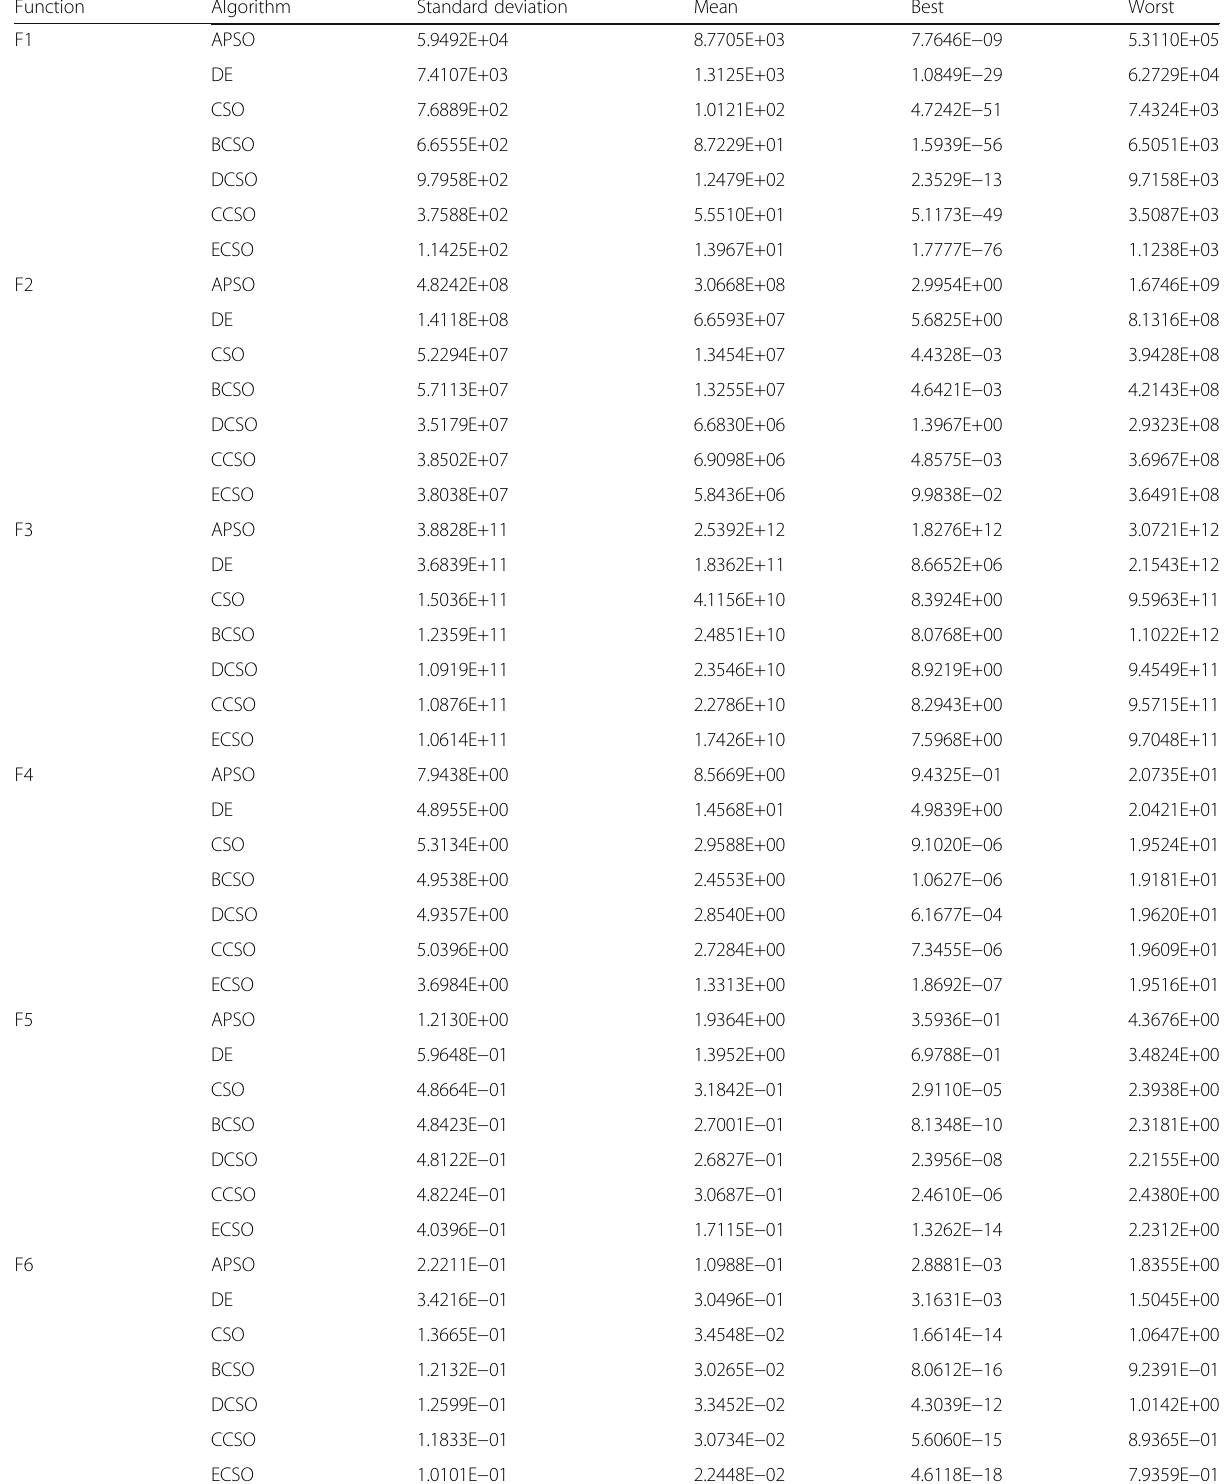
Table 3 Performance comparison of all algorithms based on benchmark functions F1 – F6